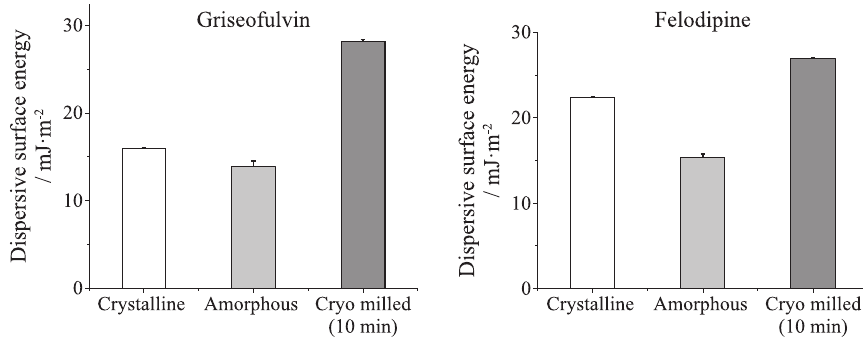
Fig. 4 Dispersive surface energy of three powders from a common source: Original crystal, milled crystal and amorphous powders of griseofulvin and